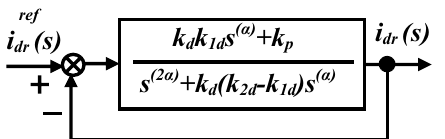
Fig. 36 Equivalent circuit of the RSC control circuit using FFOADRC